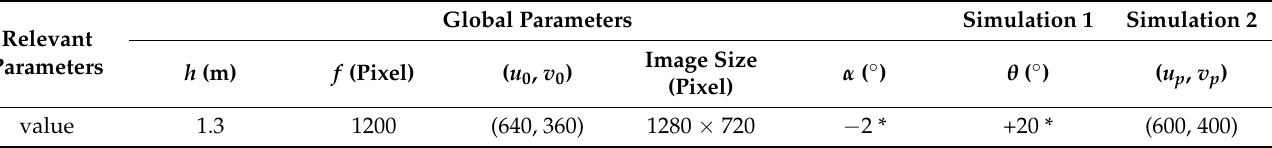
Table 1. Setting of relevant parameters.